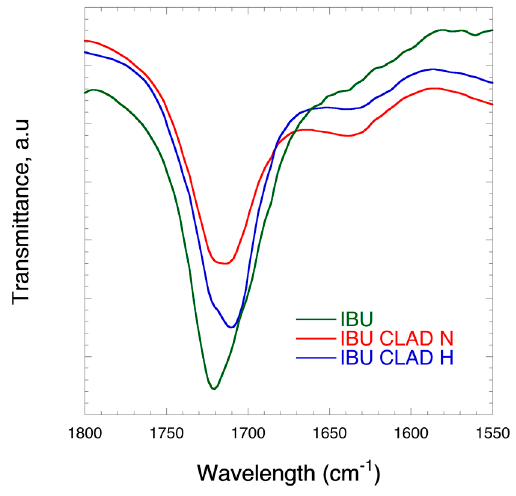
Figure 3. FTIR profiles corresponding to C=O group stretch (1800–1550 cm − 1 ) of IBU (pure), IBU-CLAD-N (non-heated), and IBU-CLAD-H (heated samples).